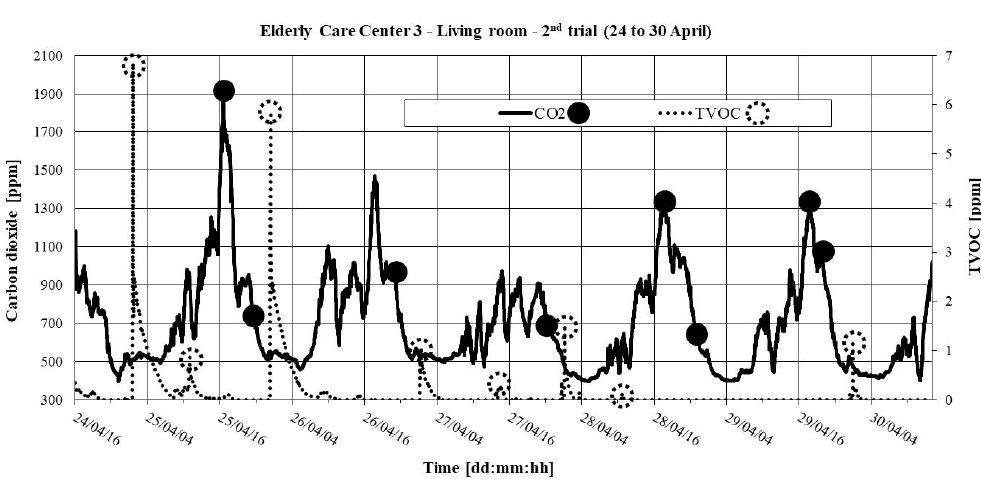
Figure 6. CO 2 and TVOC in the living room in ECC 3: 2 nd trial (24 to 30 April).